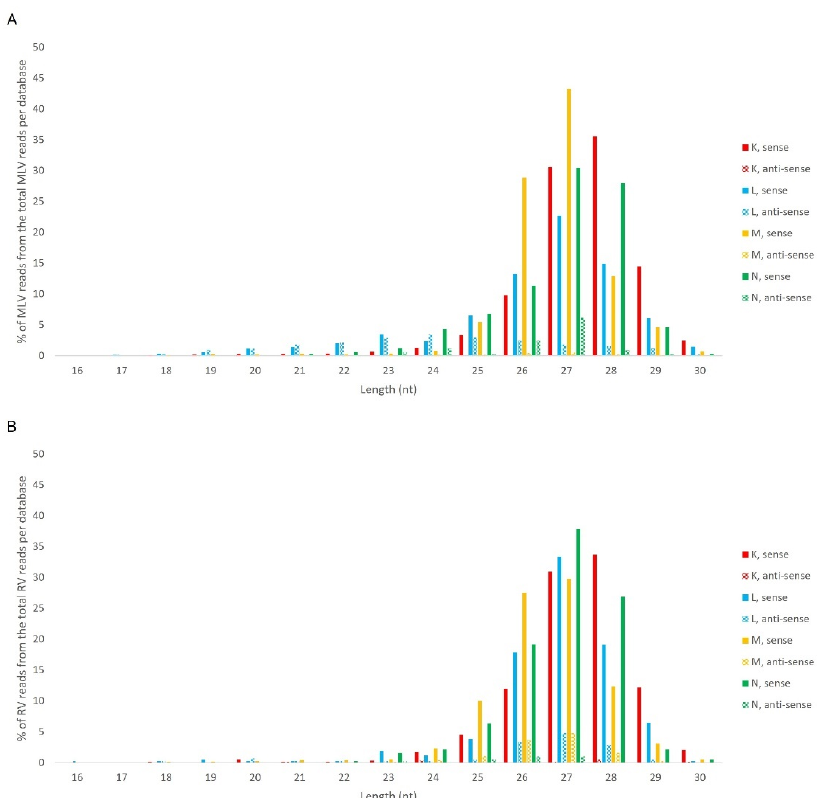
Figure 11. Length distribution of Ago3-bound sRNAs, derived from BmN4 cells, mapping to B. mori Macula-like Latent Virus (MLV) ( A ) and S. frugiperda Rhabdovirus (RV) ( B ). The Y -axis represents the percentage of viral reads for each length, in the total of the 16–30 nt viral reads. The X -axis represents the length of the reads in nucleotides. Solid bars: sense reads. Dotted bars: anti-sense reads. F–I: represented databases, listed in Table S2.